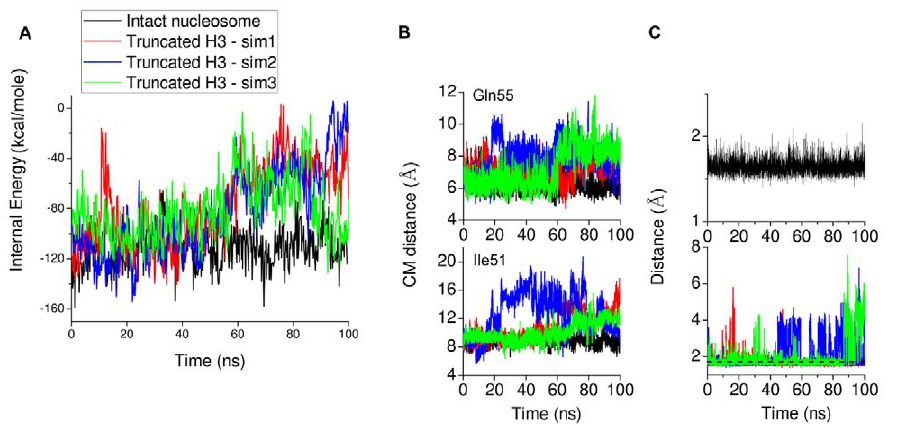
Figure 12. Destabilization of H2A docking domain interaction with Ile51, Gln55 and the DNA upon H3 tail truncation. (A) Interaction energy (vdw + electrostatics) between H2A docking domain and surrounding amino acids (B) Time series of the distance between the centers of mass of Ile51 or Gln55 and the nearest residue on the H2A C terminus (Leu115 and Asn110, respectively) is plotted. (C) Destabilization of H2A C terminus interaction with DNA upon H3 tail truncation. Time series of the minimum distance between Lys118 and Lys119 of H2A C terminus and the DNA is plotted. An increase of the distance between the C terminus end (Lys118 and Lys119) and DNA was considered to be a detachment if the minimum atomic distance between them during a tail-truncated simulation was greater than the minimum distance averaged over the intact nucleosome trajectory plus its standard deviation. The black line (dotted) indicates the minimum distance between C terminus and the DNA ( 1 : 65 z 0 : 09 A˚) below which the C terminus is ‘in contact’ with the DNA.